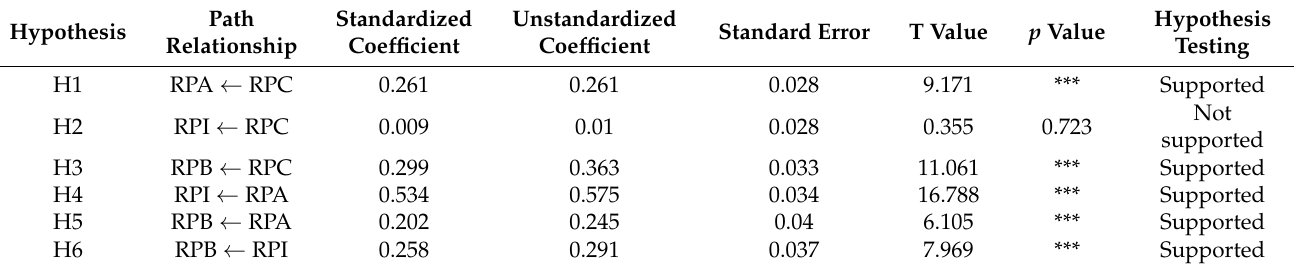
Table 3. Results of the hypotheses testing.